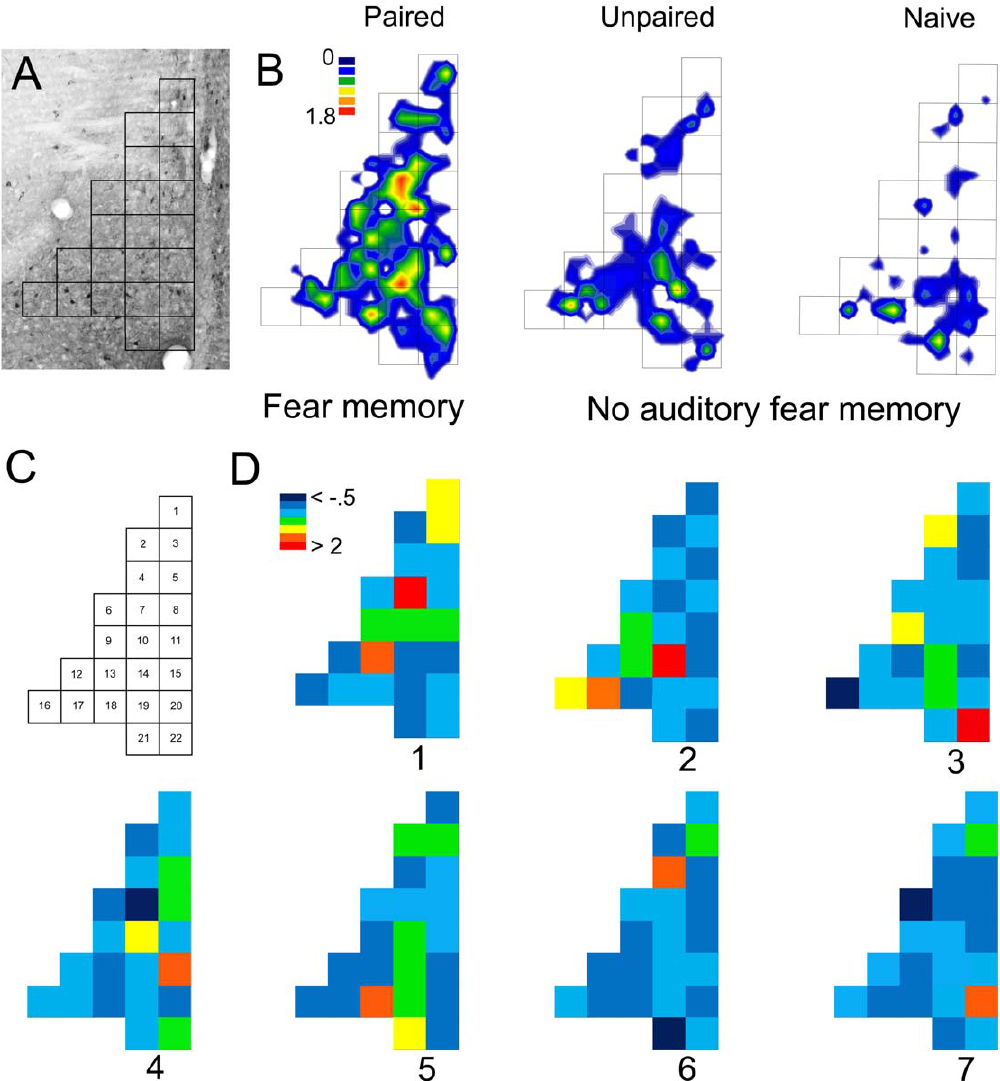
Figure 3. Spatial principal components analysis of the distribution of pMAPK labeling in the LAd. (A) Photomicrograph (4x magnification) of the LaD with grid overlay. (B) Grid showing the numerical layout of bins (120 m m 2 ) for the LAd. (C) Micro density maps with grid overlay illustrating the mean distribution of pMAPK labeled neurons for the Paired (auditory fear memory), Unpaired and Naı¨ve (no auditory fear memory) experimental conditions. (D) Component loading maps illustrating the spatial distribution of loading values for each component. The loading values can be interpreted as representing regions of variance in pMAPK activity. The loading maps are ordered according to decreasing eigenvalues with the largest eigenvalue associated with component 1. The component loading maps were generated by first categorizing the frequency of loading values for all 7 factors into bins. Each bin was color coded to reflect incremental loading values from low (dark blue) to high